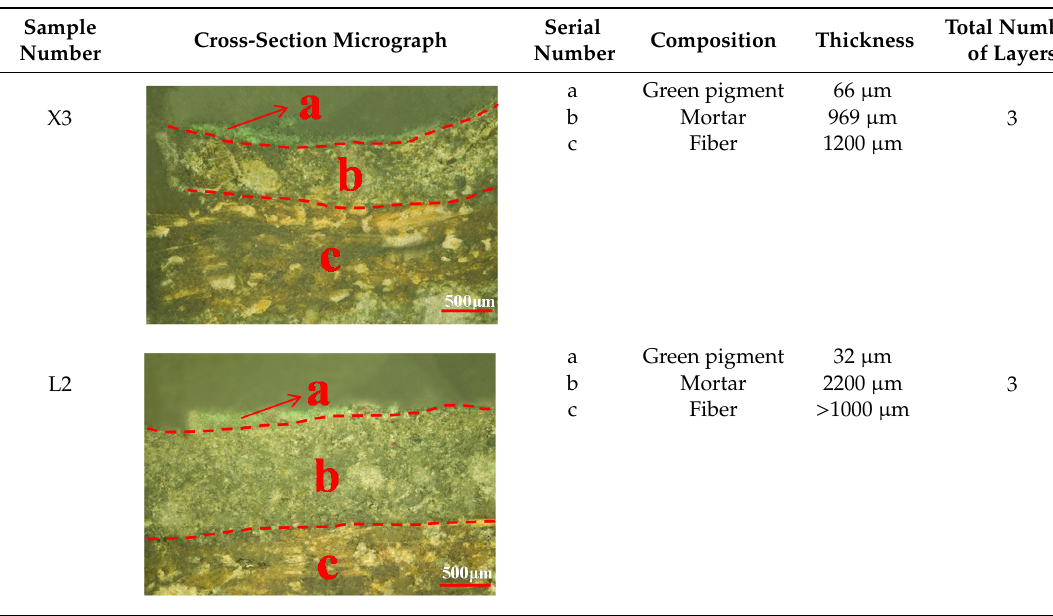
Table 2. Cross sections of L2 and X3 samples (dotted red line is used to divide the cross-sections of the layers).